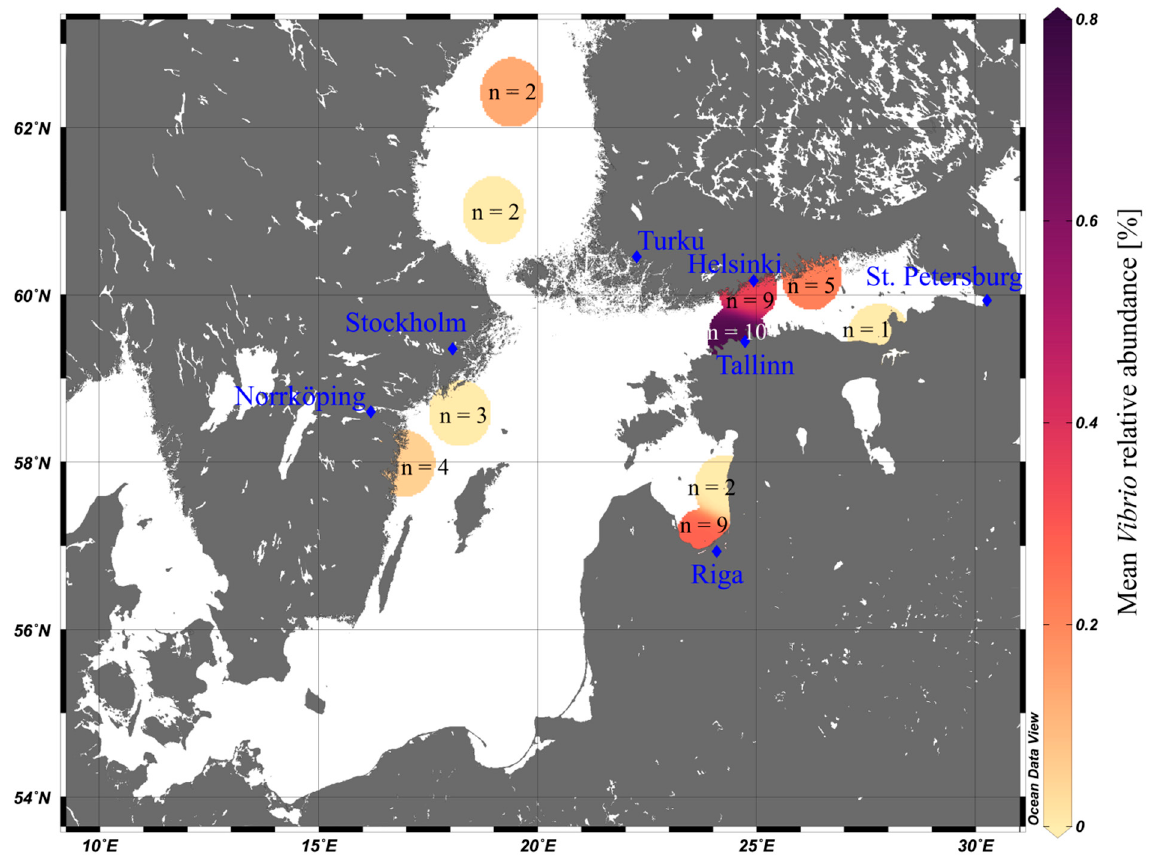
Figure 4. Mean relative abundance data of Vibrio spp. on field sampled plastics of the POS488 summer cruise (2015), covering the Gotland Sea (ex. Bay of Gdansk), Gulf of Riga, Gulf of Finland, and Bothnian Sea. Color gradient depicts mean Vibrio abundance (%) (in the case of n = 1, no mean was calculated), n = number of microplastic particles. Blue diamonds show major cities (>100,000 inhabitants) around the sampling area. The map was constructed using Ocean Data View v. 5.0.0 [24].